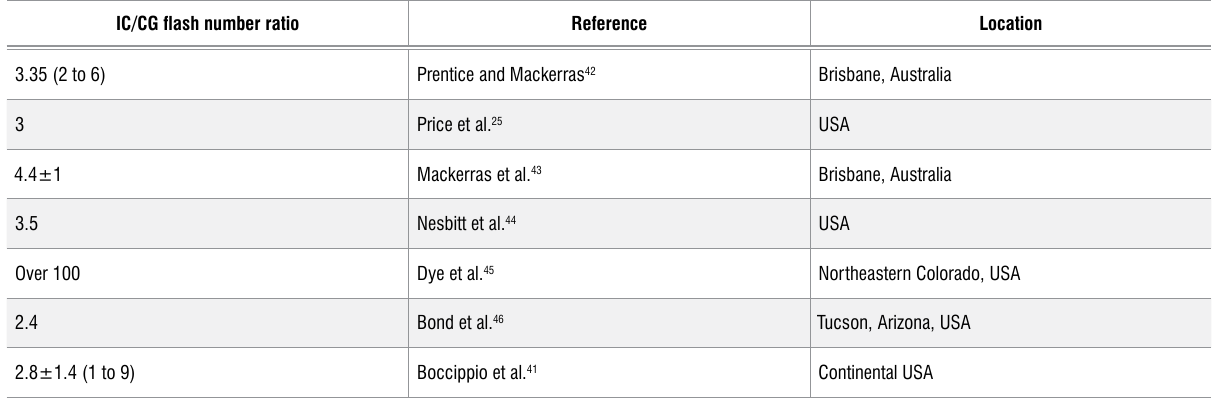
Intra-cloud to cloud-to-ground lightning flash ratio from different literature IC/CG flash number ratio